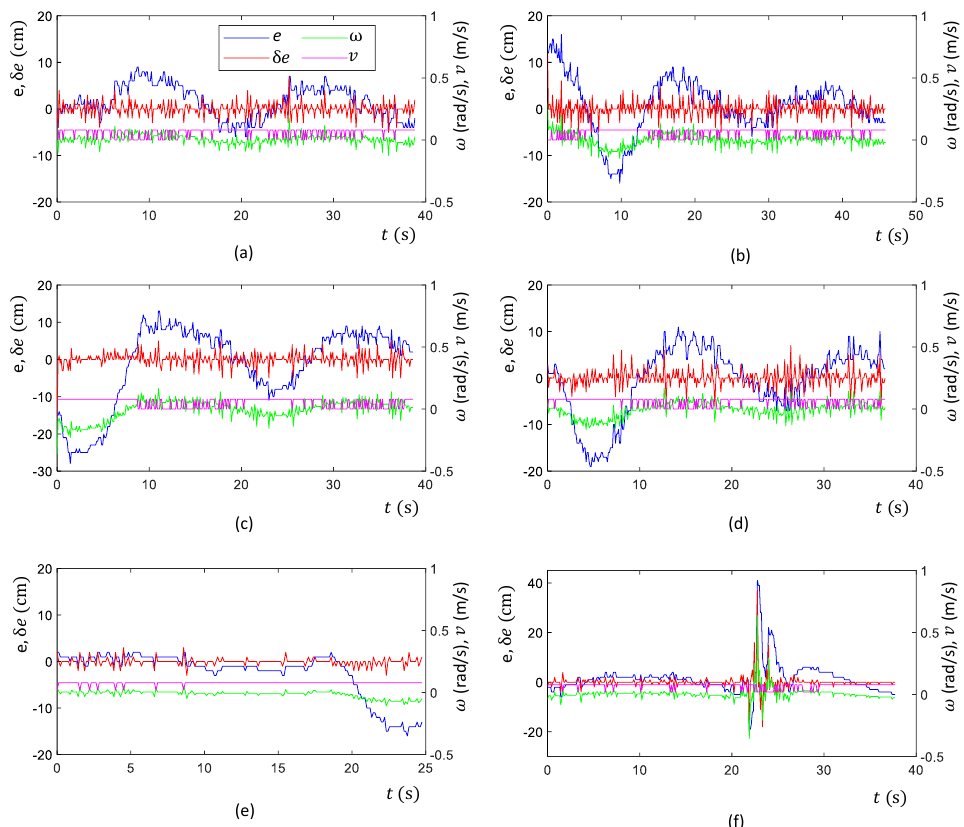
Figure 13. Variation of inputs and outputs of decision-making process of navigating in the middle of a drain in the considered test scenarios. ( a ) Scenario ‘a’, ( b ) Scenario ‘b’, ( c ) Scenario ‘c’, ( d ) Scenario ‘d’, ( e ) Scenario ‘e’, and ( f ) Scenario ‘f’. a)